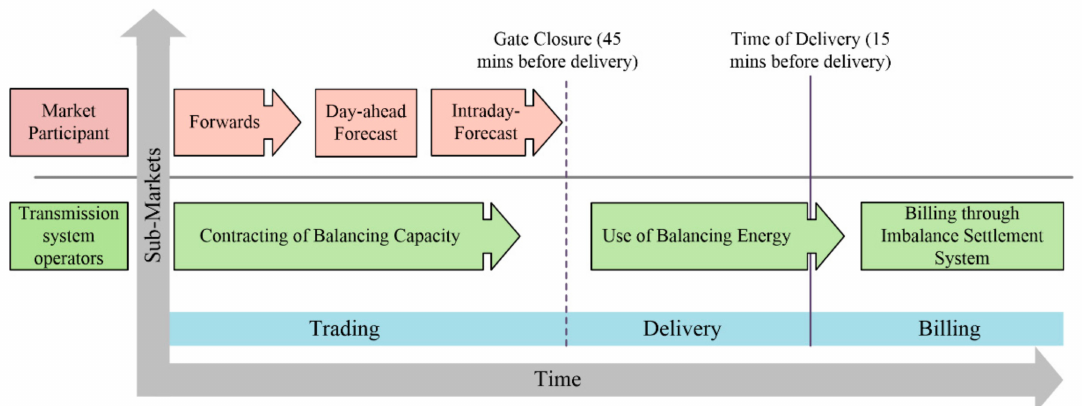
Figure 6. Overview of forecasting requirements for process energy